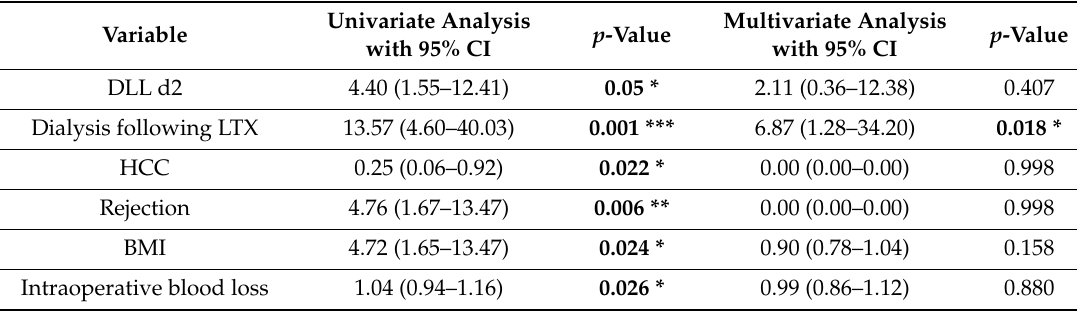
Table 4. Risk Factors for the Occurrence of > 2 Complications within 28 Days after LTX or Dead within 90